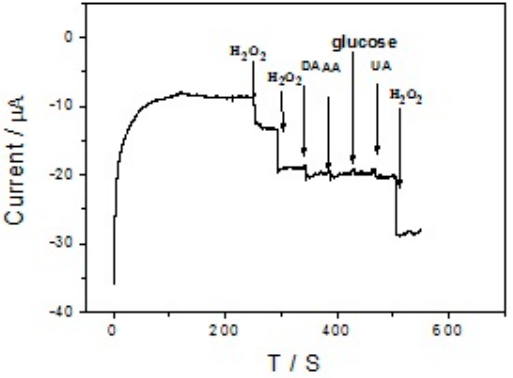
Figure 8. Amperometric curves of branch-trunk Ag hierarchical nanostructures/GCE for successive additions of H 2 O 2 and different interfering substances in the 0.1 M PBS solution (pH 7.4). The applied potential is − 0.5 V.